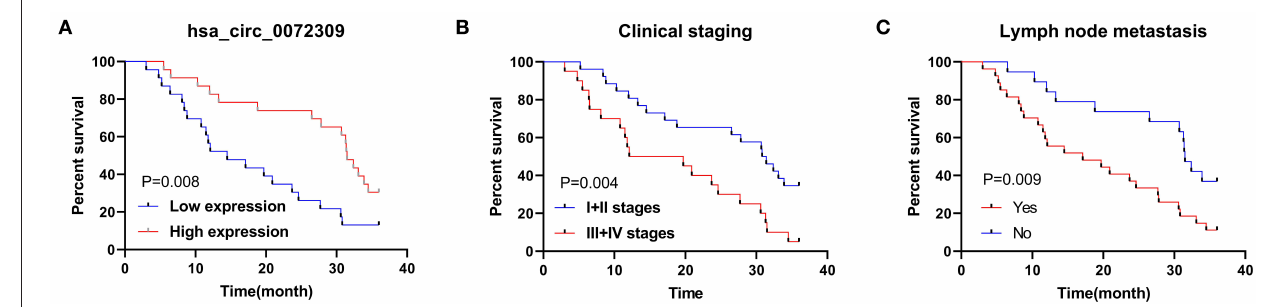
FIGURE 6 | K-M survival curve of factors with differences in univariate analysis. (A) . Three-year survival of NSCLC patients with up- and down-regulated hsa_circ_0072309 by K-M curves. (B) . Three-year survival of NSCLC patients with I-II or III-IV LC by K-M curves. (C) . Three-year survival of NSCLC patients with and without lymph node metastasis by K-M curves.